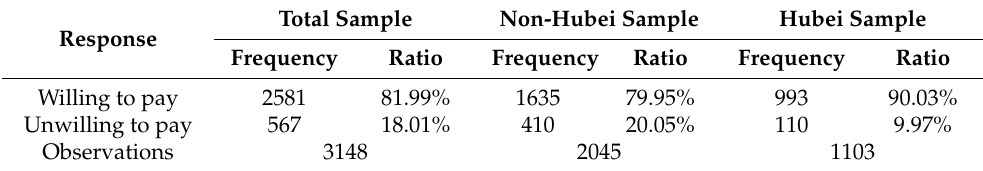
Table 5. Residents’ WTP.